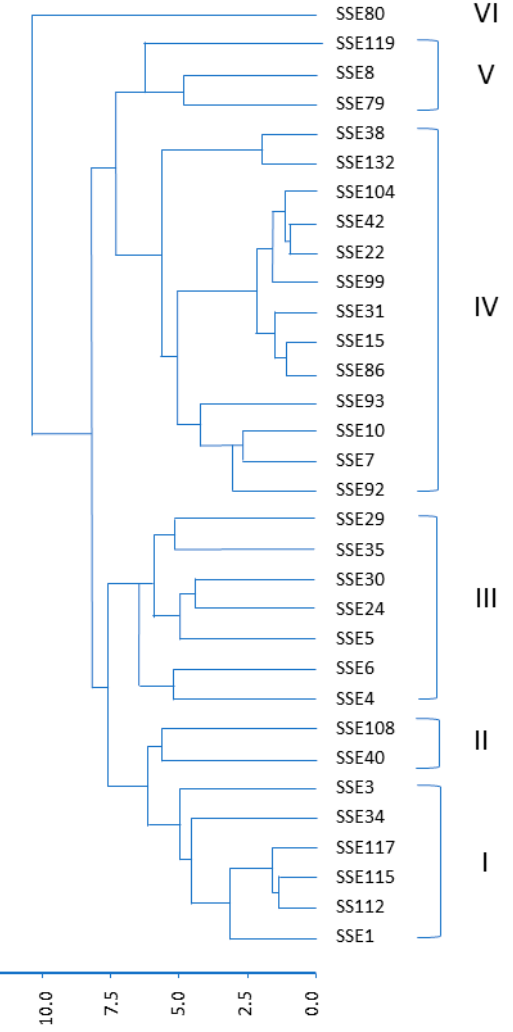
Figure 1. UPMGA (unweighted paired group method using arithmetic mean) dendrogram showing hierarchical grouping patterns of 32 SSE (Seed Savers’ Exchange) Amaranths. Axis shows distance D 2 with Mahalanobis coefficient.